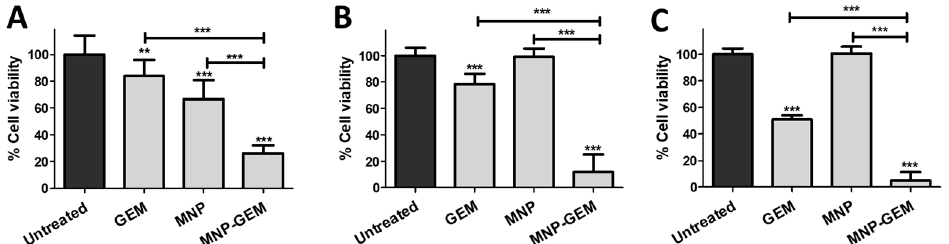
Figure 6. Cell viability assays in: ( A ) PANC-1; ( B ) BxPC-3; ( C ) MIA Paca-2 48 h after AMF (202 MHz, 29.9 mT, 20 min) was applied. Conditions in PANC-1: MNP 0.5 mg Fe/mL, GEM 22.5 μ M, and MNP-GEM 0.5 mg Fe/mL 22.5 μ M. Conditions in BxPC-3 and MIA Paca-2: MNP 0.1 mg Fe/mL, GEM 4.5 μ M and MNP-GEM 0.1 mg Fe/mL 4.5 μ M. Data represent means ± SD. Statistical analysis was performed using one-way ANOVA test (each group vs. control). ** p < 0.01, *** p < 0.001.